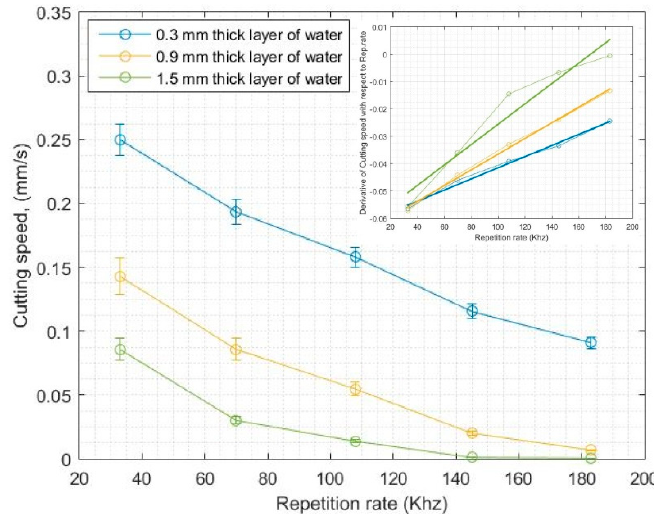
Figure 9. Cutting speed (for 1-mm thick, soda-lime glass samples) vs. repetition rate (pulse energy) when a layer of water of different thickness is placed above the samples. The average power is constant at 10 W for all cases.